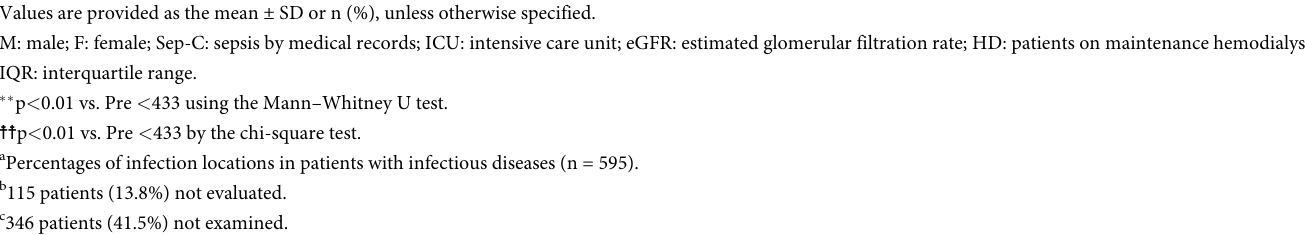
(19.2% vs. 6.7%, p < 0.01).